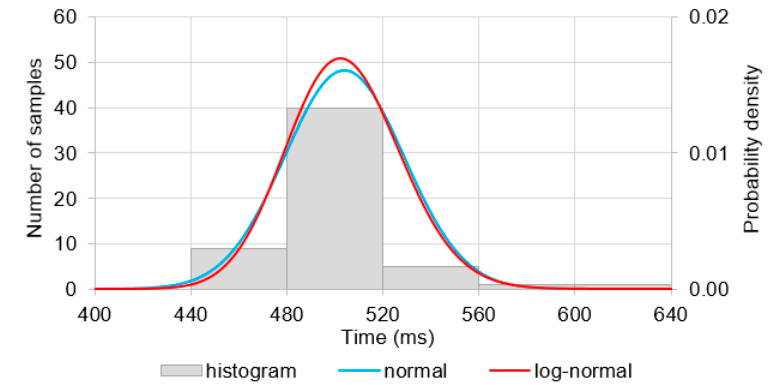
Figure 6. Histogram and the normal and log-normal operating time distributions for LZ-32 protection with 500 ms setting.